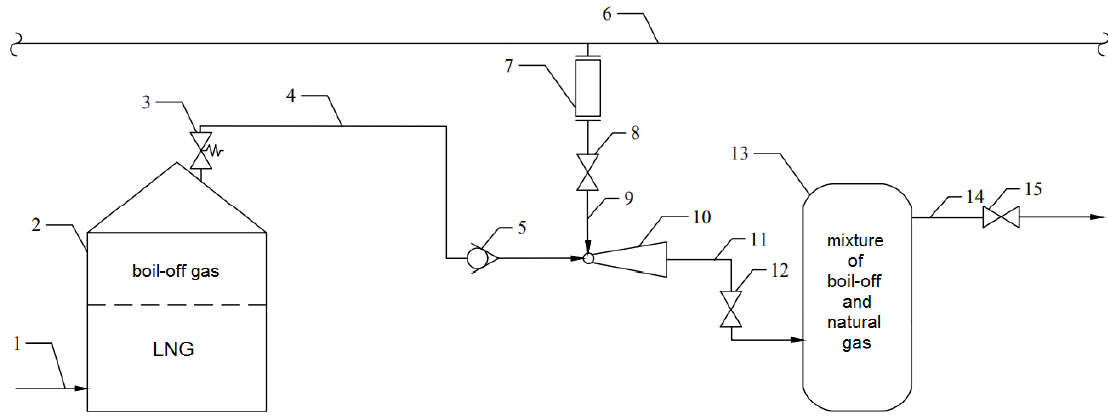
Figure 2. Flow diagram of liquefied natural gas (LNG) vapor disposal using an ejector [(by the au- thors, Y.V. Martynenko, V.I. Bolobov, and V.A. Voronov): 1 — LNG tank fill line; 2 — LNG tank; 3 — pressure safety valve for relieve of excess boil-off gas; 4 — boil-off gas feed line to ejector; 5 — check valve; 6 — high-pressure natural gas line; 7 — natural gas pressure reducer; 8 — gate valve at natural gas feed line to ejector; 9 — natural gas feed line to ejector; 10 — gas ejector; 11 — rundown line for boil-off gas and natural gas mixture from ejector; 12 — gate valve at the rundown line for boil-off gas and natural gas mixture to the storage tank; 13 — storage tank for boil-off gas and natural gas mix- ture; 14 — rundown line for boil-off gas and natural gas mixture for process needs and re-liquefac- tion; 15 — gate valve on the rundown line for boil-off gas and natural gas mixture for process needs and re-liquefaction.